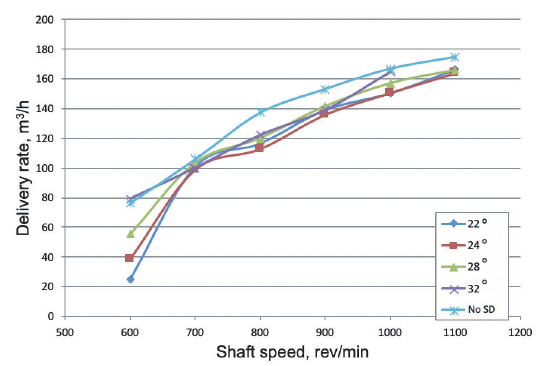
Figure 3. Delivery rate as a function of the pump shaft for dif- ferent SD designs.